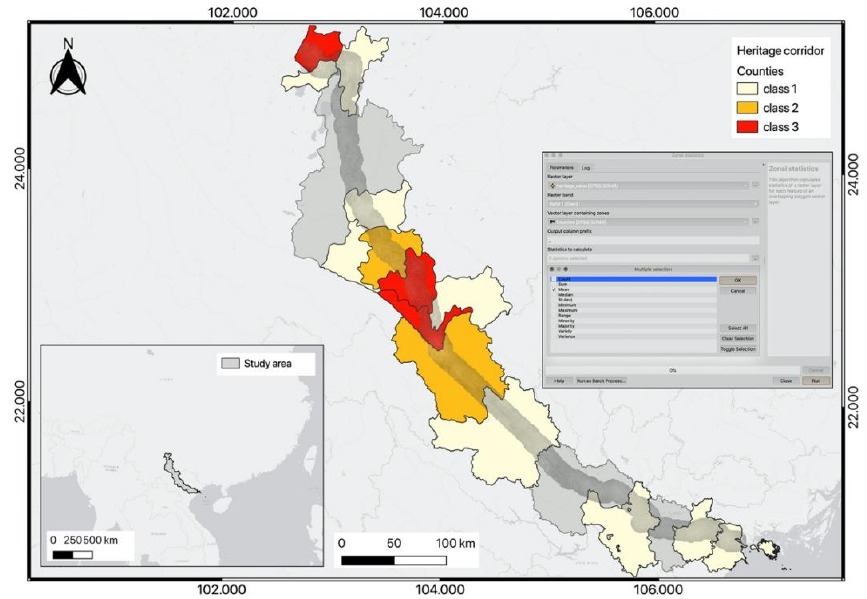
Figure 4. Zonal statistic of the landscape value in the study area. The classes are divided according